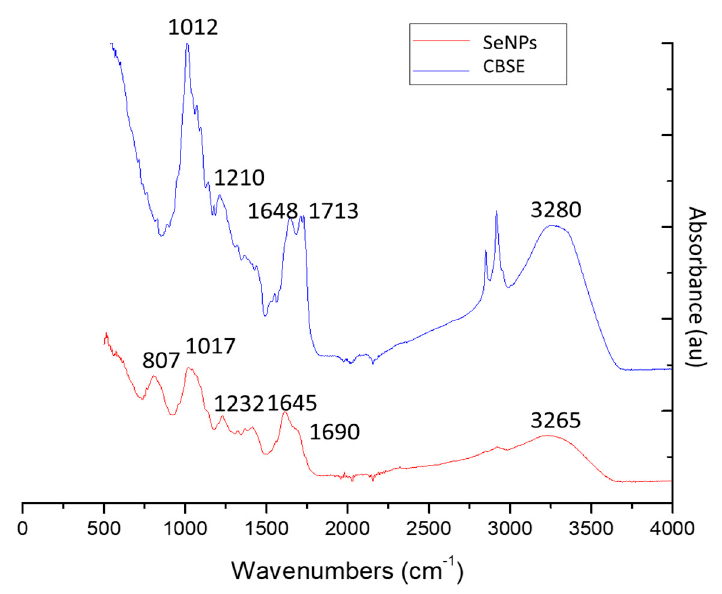
Figure 5. FTIR spectra of CBSE and SeNPs obtained under optimal conditions.